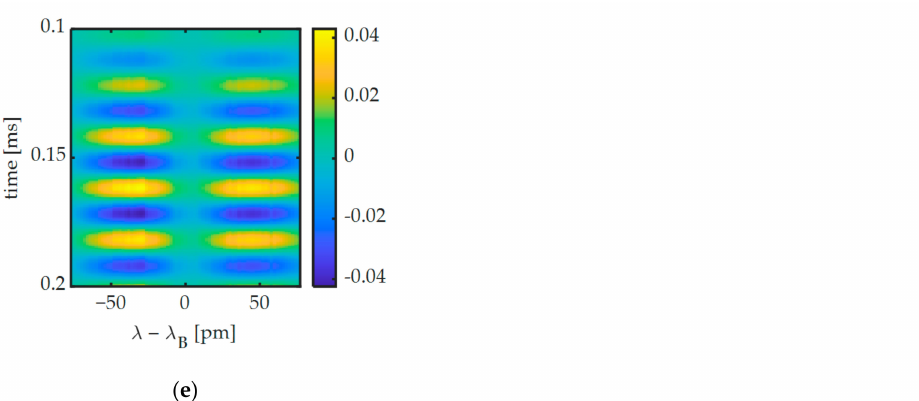
Figure 9. First wave packet of AC coupled 250 kHz UGW signals measured along the spectrum of ( a ) the 2-mm, ( b ) the 3-mm, ( c ) the 5-mm, ( d ) the 8-mm and ( e ) the 10-mm FBG.